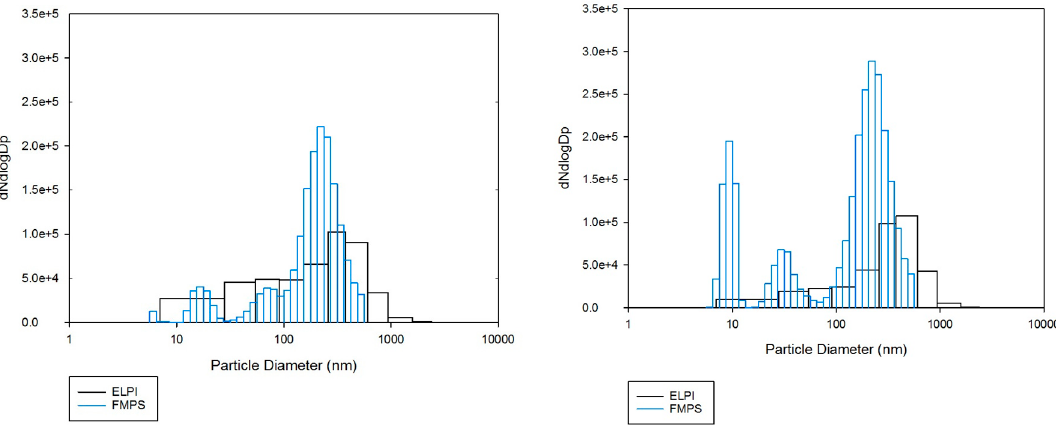
Figure 4. Particle size distributions measured by the ELPI and the FMPS during two different days of measurement. Results from day 1 are shown on the left, day 2 on the right.